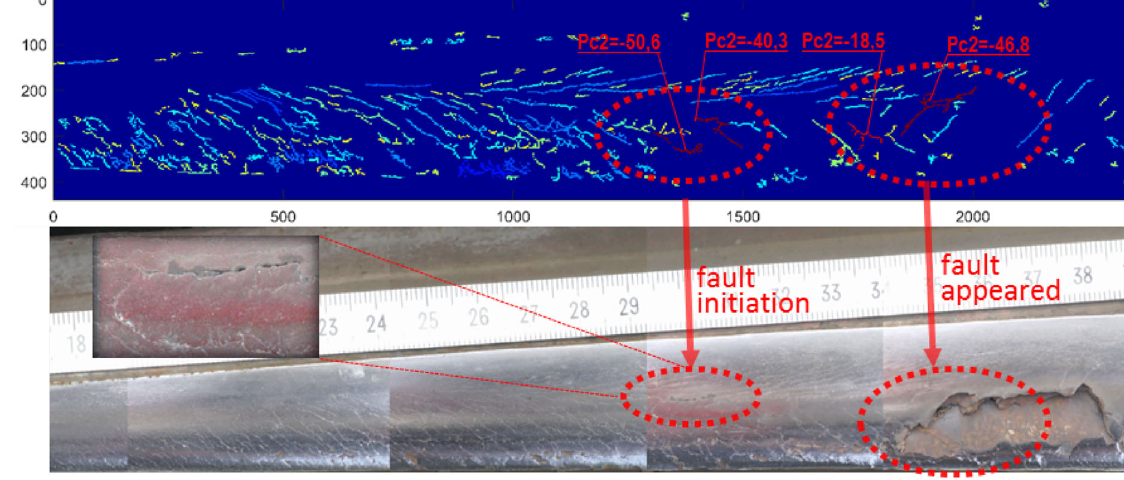
Fig. 14 The predicted faults with MPI imaging at 43 Mt (above) and appeared faults after 52 Mt